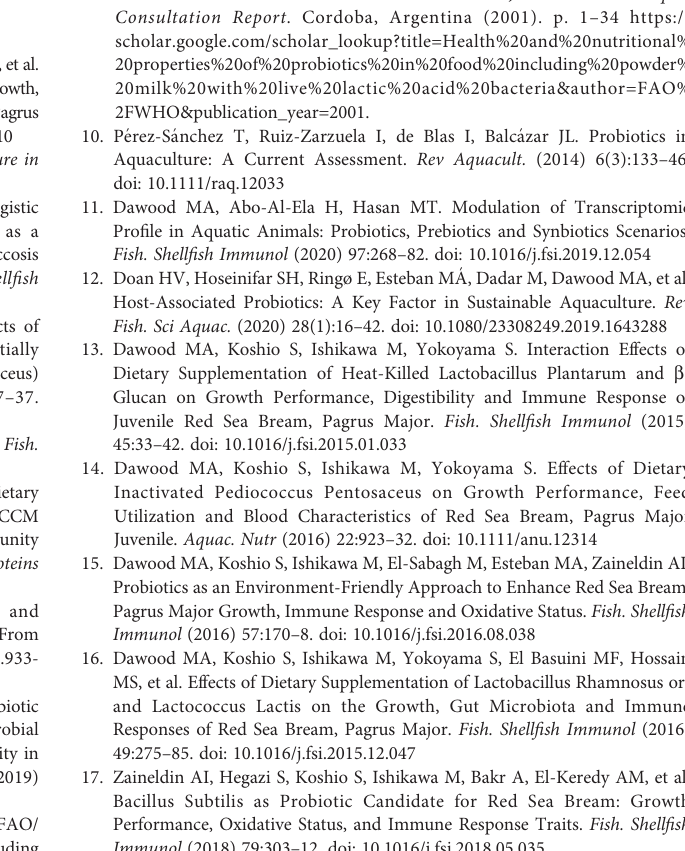
Supplementary Figure 1 | Phylogenetic tree and genome circular map of Bacillus sp. PM8313. (A) The phylogenetic tree was constructed by the neighbor joining method using MEGA 7 with 1,000 bootstrap repetitions, after which the 16S rRNA sequences were aligned by the Clustal W program. (B) Genome circular map was constructed using GView server. From the center to the outside: the number of bases, GC content, GC skew, location of all annotated ORFs (colored by COG